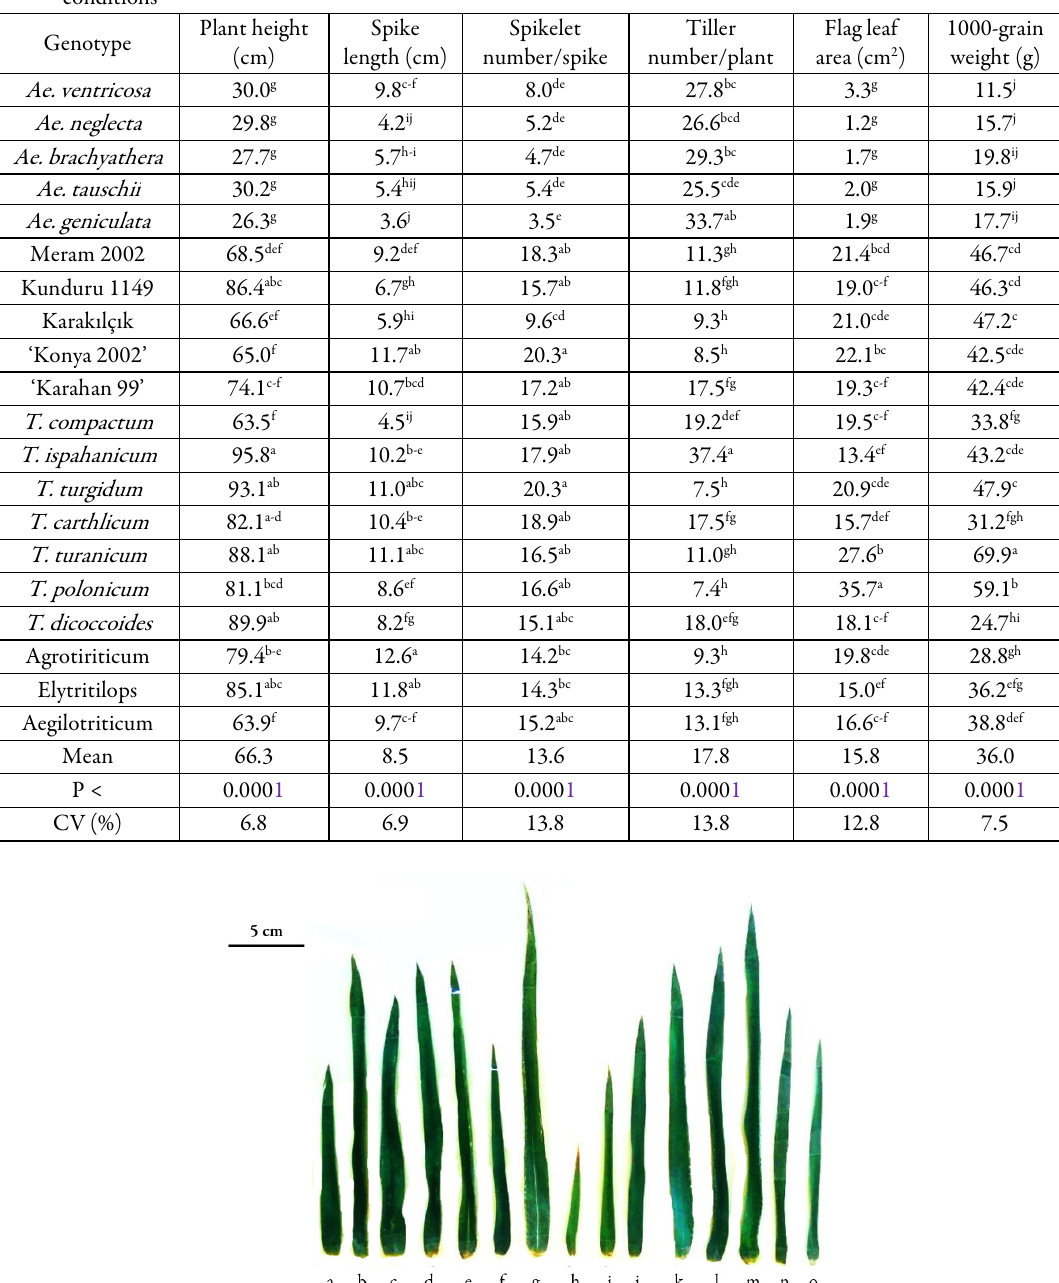
Table 3. Morphological traits of wheat species, Aegilops species, and wheat hybrids under irrigated